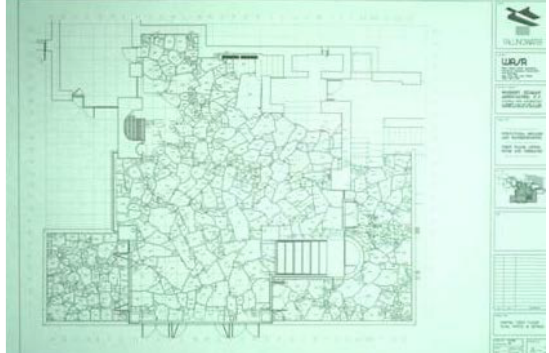
Figure 4. Documentation of the living-room flagstone floor and east and west living-room terraces (Wank